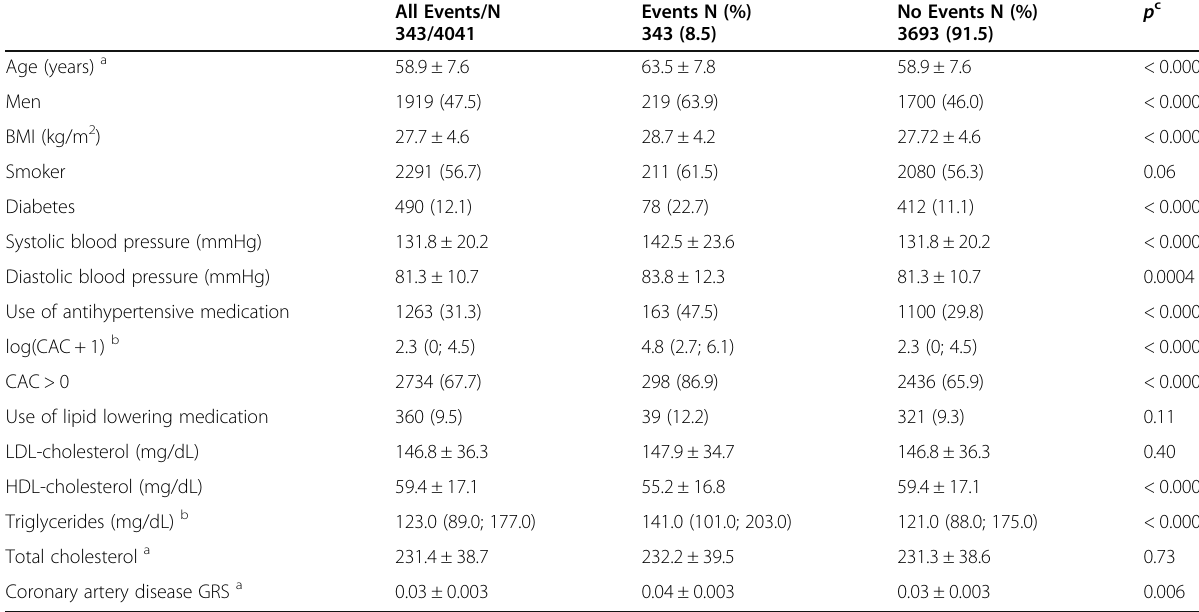
Table 1 Characteristics of the Heinz Nixdorf Recall study population